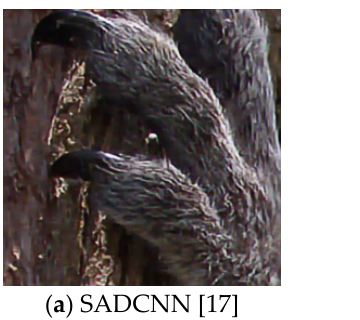
Figure 7. Comparison with detail restoration between SADCNN and Ours.